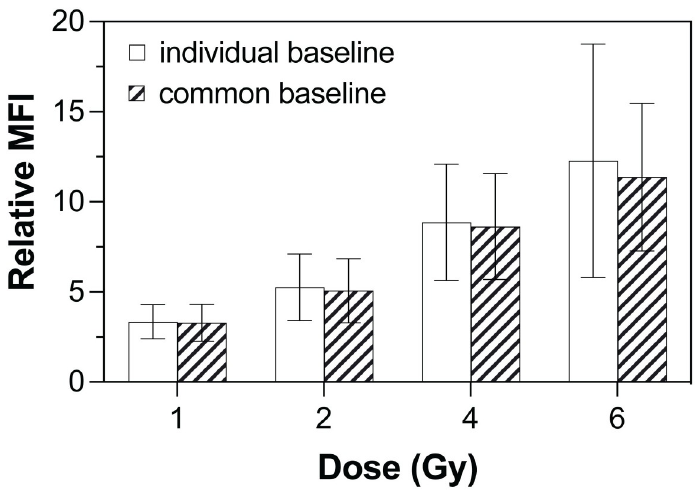
Fig 4. Error bar representing comparison of relative γ -H2AX expression in lymphocytes at each absorbed dose calculated based on individual vs common baseline expression at 0 Gy (n =